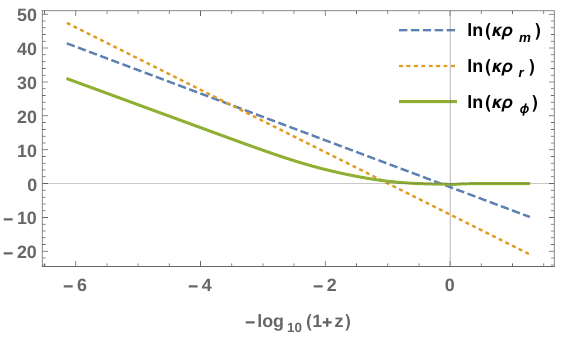
Figure 2. The evolution of the energy densities for the model with non-negligible X 0 , X 1 , and X 2 . Figure from